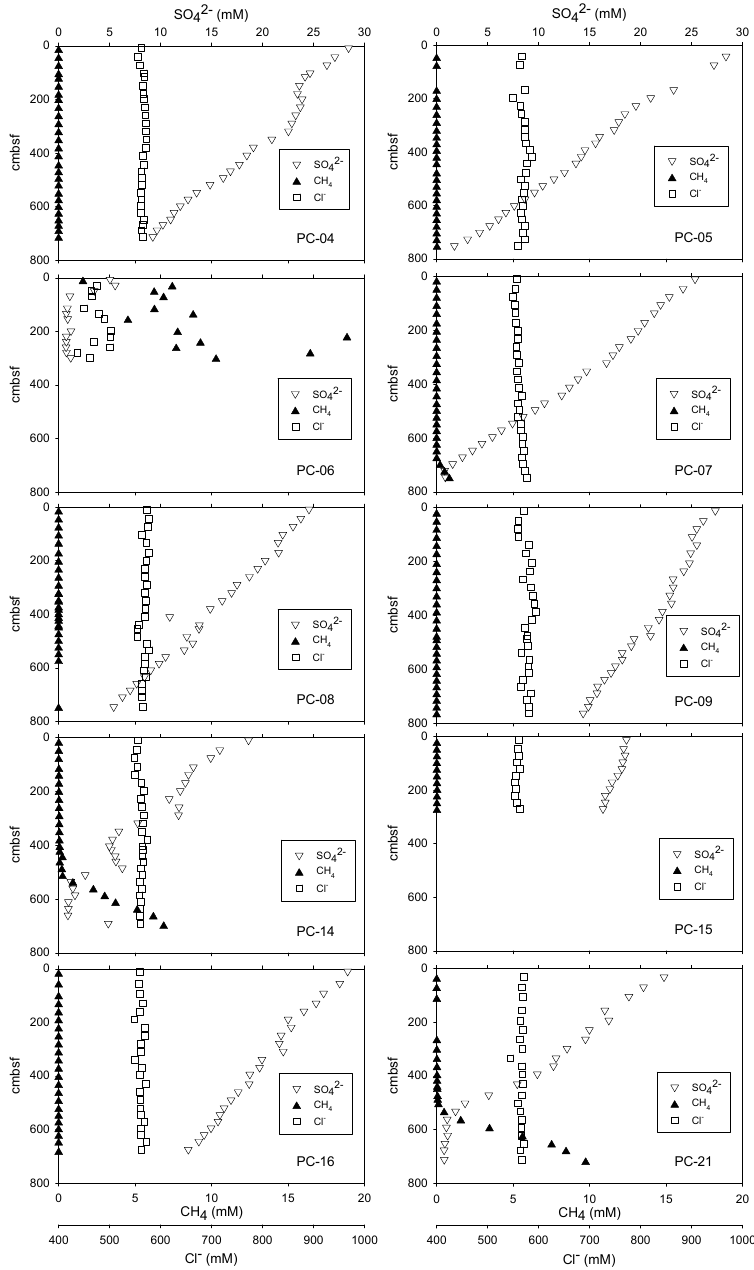
Figure 3. Sediment headspace CH 4 and porewater SO 42 − and Cl − concentrations vs. depth (centimeters below sea floor, CMBSF) for AC-07 piston cores (PC). Core PC-06 contained solid phase hydrates which destabilized during